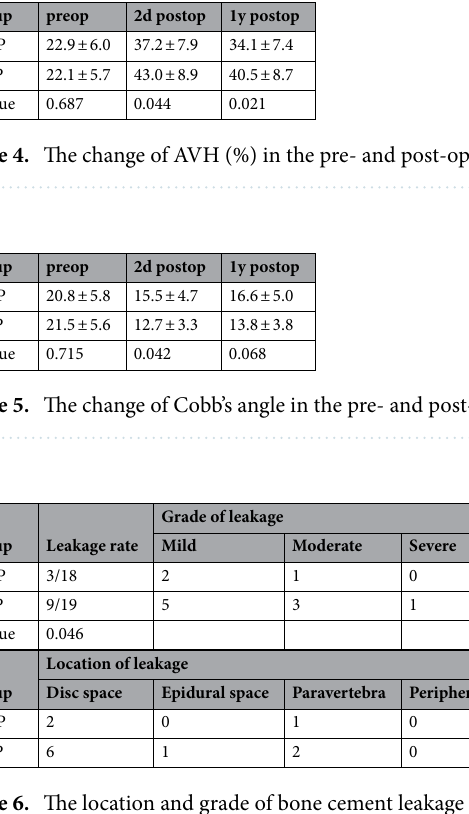
Table 6. The location and grade of bone cement leakage in two